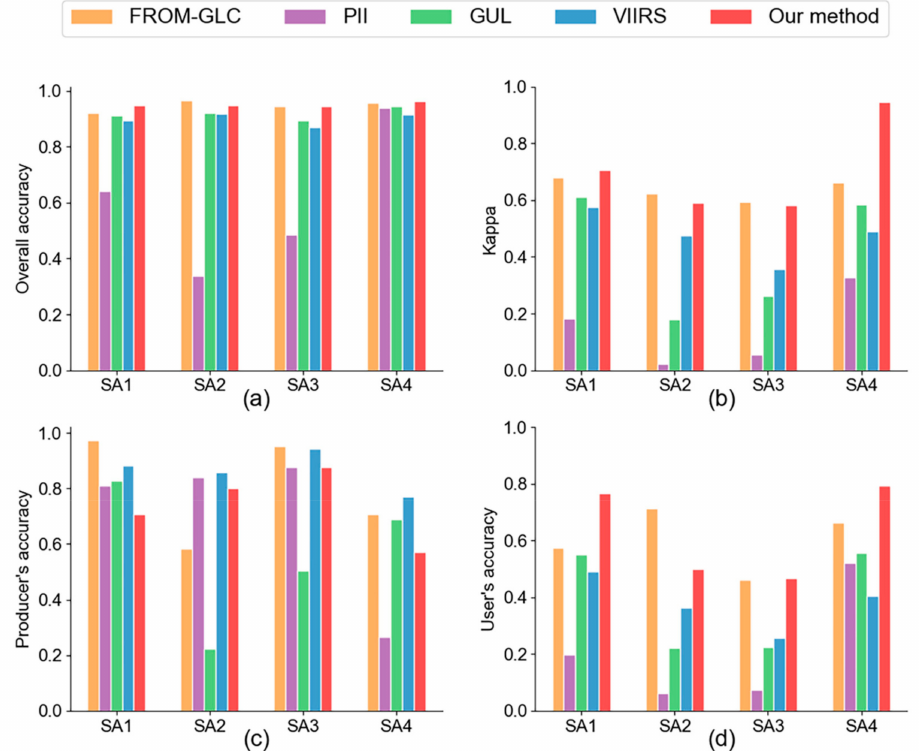
Figure 5. Comparison of built-up area accuracy and associated measures for FROM-GLC, PII, GUL, and VIIRS. ( a ) Overall accuracy; ( b ) Kappa coe ffi cient; ( c ) Producer’s accuracy; ( d ) User’s